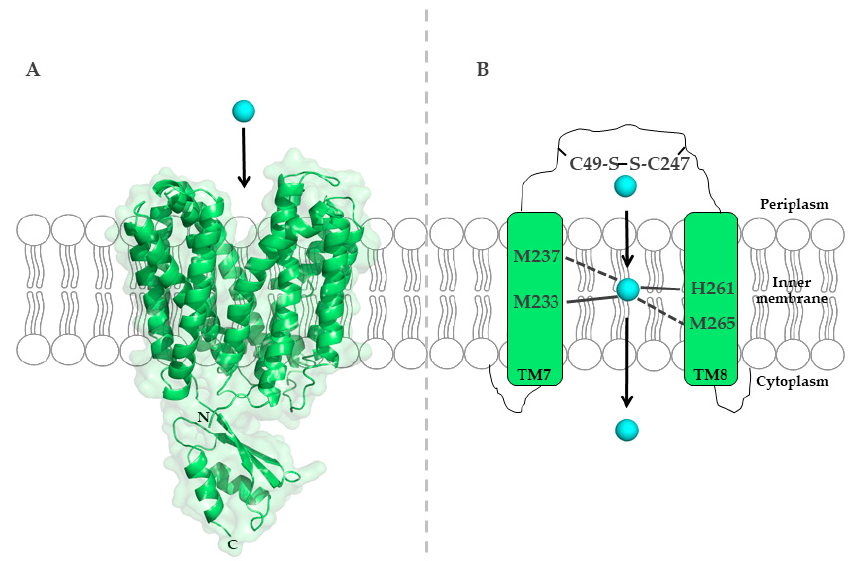
Figure 4. The major-facilitator-superfamily (MFS)-like Cu importer CcoA from R. capsulatus . ( A ) Structure of E. coli YajR (PDB 3WDO), which is homologous to R. capsulatus CcoA, but contains a large cytosolic domain, which is absent in CcoA. ( B ) Schematic representation of the metal-binding site in R. capsulatus CcoA, which is composed of methionine and histidine residues in transmembrane helices 7 and 8. Cysteine residues in the periplasmic loop likely contribute to Cu transport via CcoA.